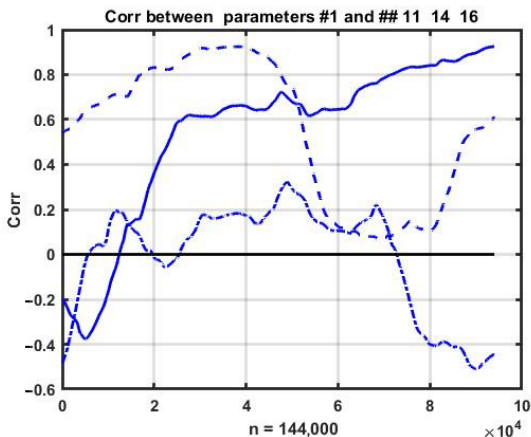
Figure 3. Changes in pair correlations between the parameters of a chaotic